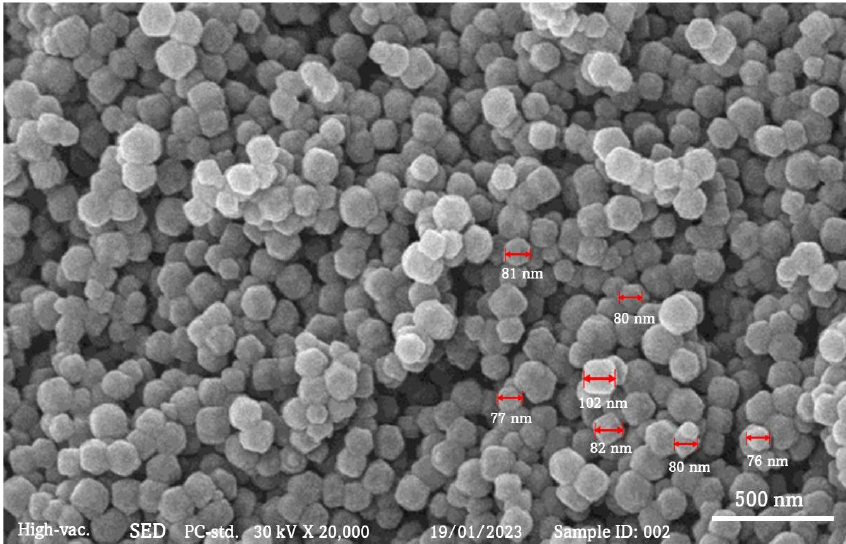
Figure 4. Scanning electron microscopy image of the zeolite imidazole framework (ZIF-8).